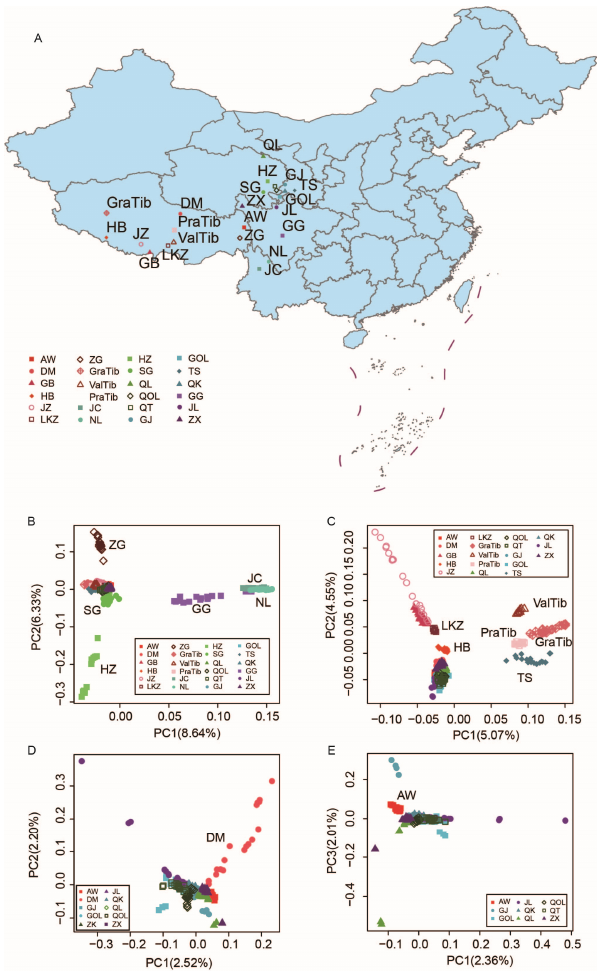
Figure 1. ( A ) A map of the studied area along with the distribution of the 24 sheep populations. ( B ) PCA plot of the first 2 components of 24 sheep breeds. ( C ) PCA plot of the first 2 components of 18 sheep breeds. ( D ) PCA plot of the first 2 components of 10 sheep breeds. ( E ) PCA plot of the first and the third component of nine sheep breeds. The fraction of the total variance explained is reported on each individual axis between parentheses. The red color represents Tibetan sheep in Tibet (N = 180—AW, Awang sheep from Gongjue County in Tibet, 19; DM, Duoma sheep from Anduo County in Tibet, 19; GB, Gangba sheep from Gangba County in Tibet, 37; HB, Huoerba sheep from Zhongba County in Tibet, 19; JZ, Jiangzi sheep from Jiangzi County in Tibet, 18; LKZ, Langkazi sheep from Langkazi County in Tibet, 9; ZG, Zuogong sheep from Zuogong County in Tibet, 18; ValTib, Shangu sheep from Gongga County in Tibet, 8; PraTib, grassland sheep from Dangxiong County in Tibet, 10; GraTib, grassland sheep from Gaize County in Tibet, 23). The cyan color represents Tibetan sheep in Yunnan (N = 36—JC, Jianchuan sheep from Jianchuan County in Yunnan, 18; NL, Ninglang sheep from Ninglang Autonomous County in Yunnan, 18). The green color represents Tibetan sheep in Qinghai (N = 90—HZ, Heizang sheep from Guinan County in Qinghai, 18; SG, Shangu sheep from Maqin County in Qinghai, 18; QL, Qilian sheep from Qilian County in Qinghai, 18; QT, Qinghai Tibetan sheep from Zeku County in Qinghai, 18; QOL, Oula sheep from Henan County in Qinghai, 18). The blue color represents Tibetan sheep in Gansu (N = 75: GOL, Oula sheep from Maqu County in Gansu, 18; GJ, Ganjia sheep from Xiahe County in Gansu, 18; QK, Qiaoke sheep from Luqu County in Gansu, 18; TS, Tao sheep from Zhuoni County in Gansu, 21). The purple color represents Tibetan sheep in Sichuan (N = 55—GG, Gongga sheep from Luding County in Sichuan, 18; JL, Jialuo sheep from Aba County in Sichuan, 18; ZXK, Zhaxika sheep from Shiqu County in Sichuan, 19). The shapes of the symbols indicate the geographic